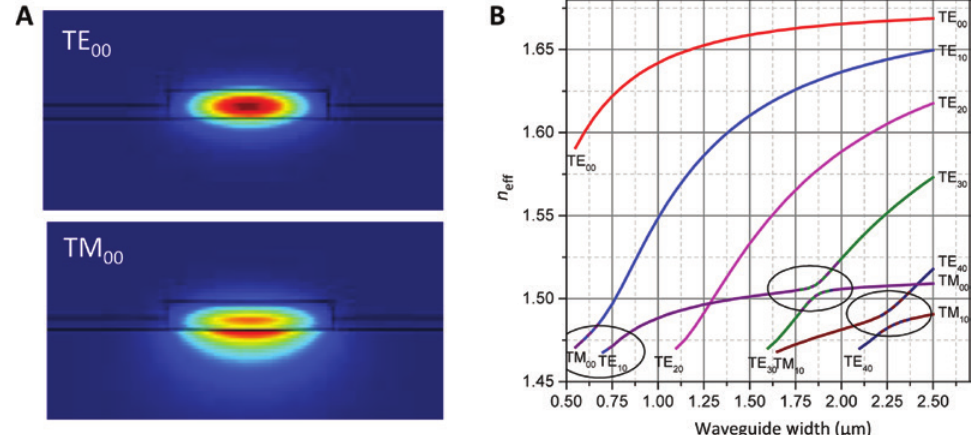
mode and quasi-TM mode in a 1- μ m-wide waveguide at a wavelength of 780 nm. (B) The Figure 2: (A) The intensity of the quasi-TE 00 00 dependence of n on the rib width for each allowed waveguide mode at a wavelength of 780 nm. Circled regions depict widths for which the eff modes are strongly